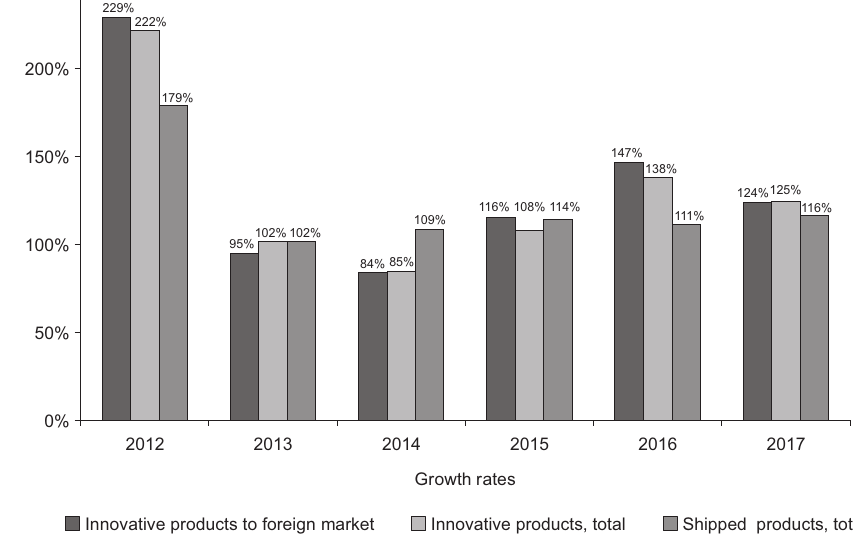
Fig. 4. Dynamics of shipped and innovative industrial products of the Republic of Belarus (growth rates). Source: own study based on the National Statistical Committee of the Republic of Belarus